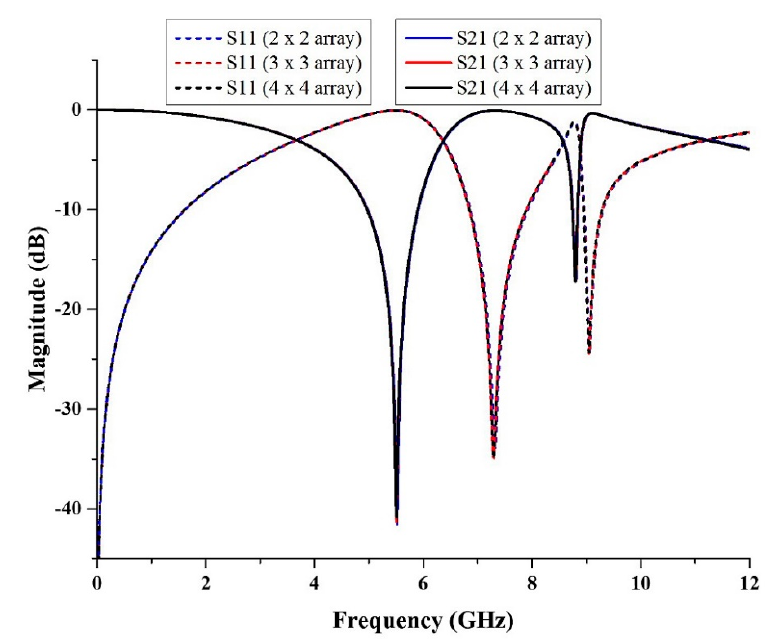
Figure 8. The comparison of the S-parameter results for 2 × 2, 3 × 3 and 4 × 4 arrays.